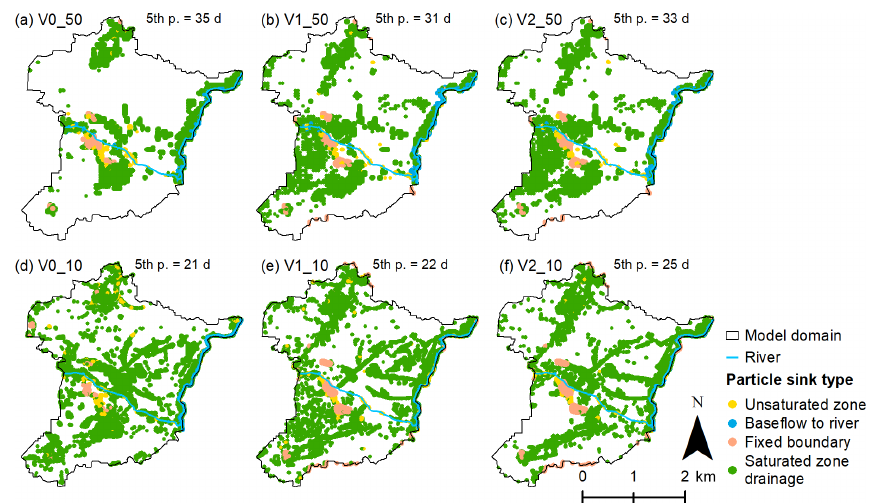
Figure 13. Release locations of particles that are within the 5th percentile of the travel times to sinks and their end-sink type. The sink type saturated-zone drainage includes leaking sewers.